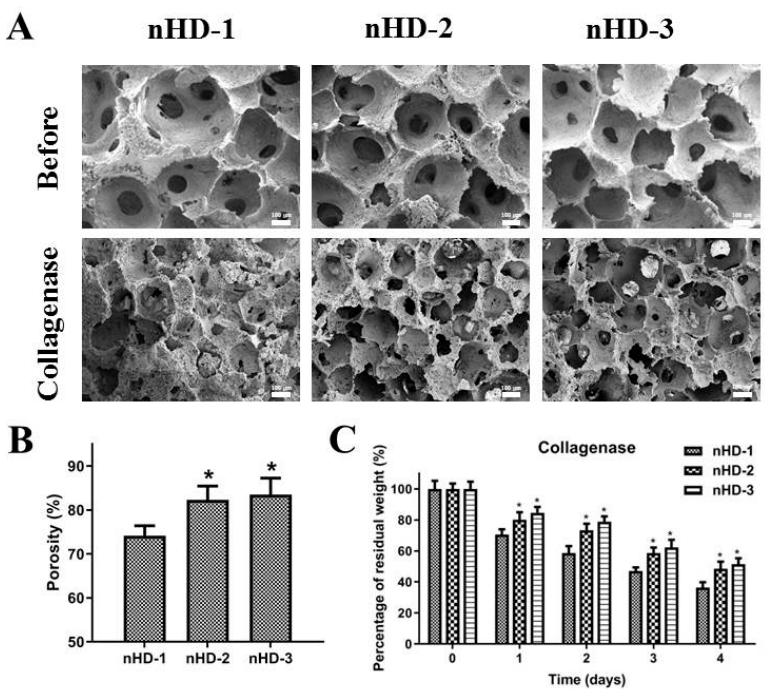
Figure 5. ( A ) SEM micrographs of the three nHD scaffolds at 37 °C before and after degradation by collagenase; the scale bar is 100 μ m. ( B ) The porosity of the three nHD scaffolds. ( C ) The percentage of residual weight for the three nHD scaffolds in vitro collagenase degradation test; * p < 0.05 compared with nHD-1 scaffolds.